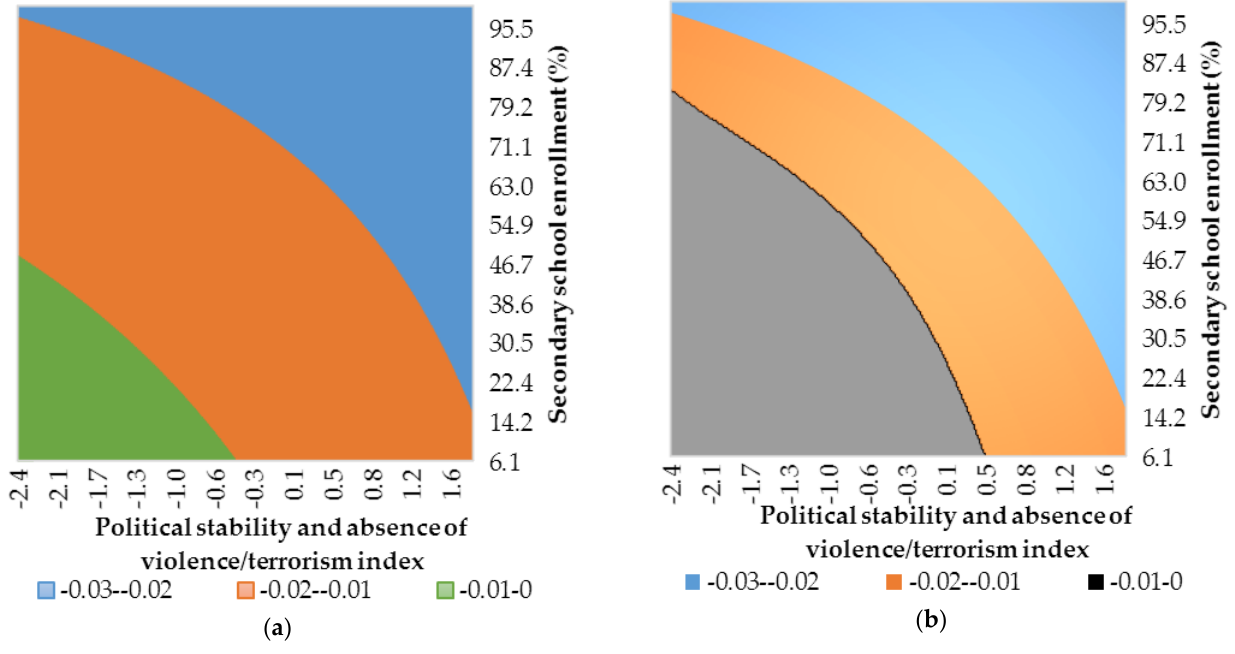
Figure A3. Conditional effect of financialisation on growth based on Est. 3 in Table A2. ( a ) Estimated conditional slope coefficient over the whole range of observed values for institutional quality and development level. ( b ) Estimated statistically significant conditional slope coefficient. Gray represents a combination of institutional quality and development level for which effect of financialisation on growth is statistically insignificant. Source: authors’ contributions.